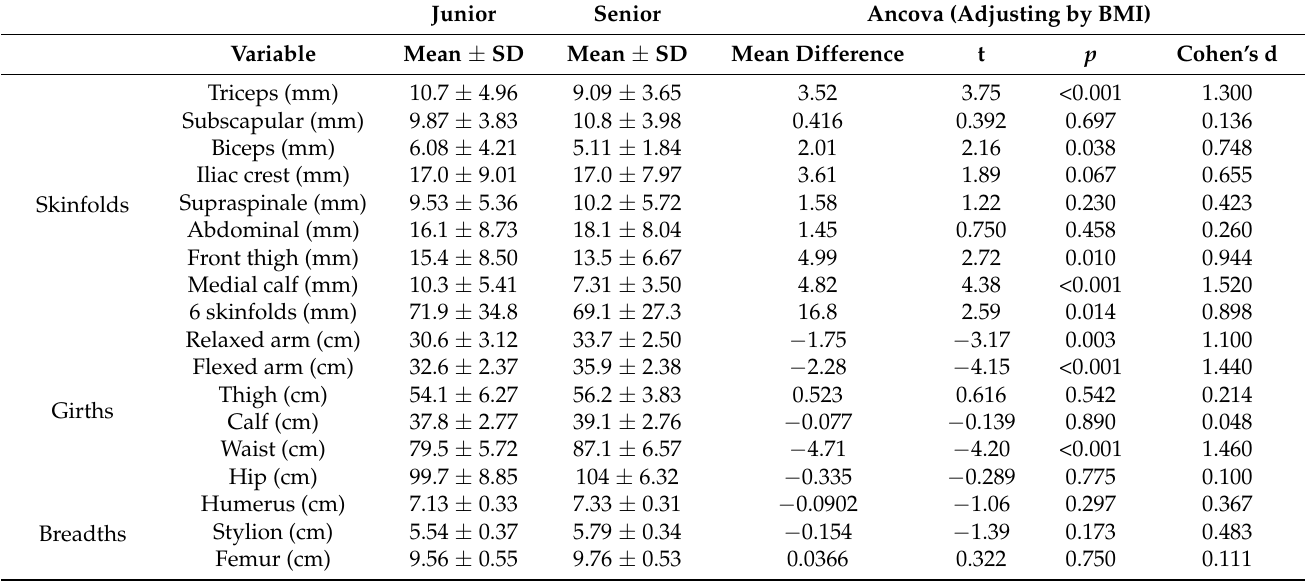
Figure 2. Somatotype distribution of elite male senior beach handball players. However, if somatotype is analyzed as a function of playing position, as shown in the figure, the trends are different. For juniors, goalkeepers present a balanced endomorph somatotype, while right and left wings and defenders are mesomorph-ectomorph. In the senior category, defenders and right wings have a mesomorphic-endomorphic somatotype, while specialists and left wings tend to have a mesomorphic-ectomorphic somatotype. Table 5 There are significant differences in some skinfolds such as triceps ( p < 0.01), biceps ( p < 0.05), front thigh ( p < 0.05) and medial calf ( p < 0.01), as well as in the sum of 6 skinfolds ( p < 0.05). There was a general tendency for senior players to have lower skinfold values. Overall effect sizes were moderate to large. Table 5. Descriptive data on skinfolds, circumferences, diameters, and the differences between junior and senior are presented in Table